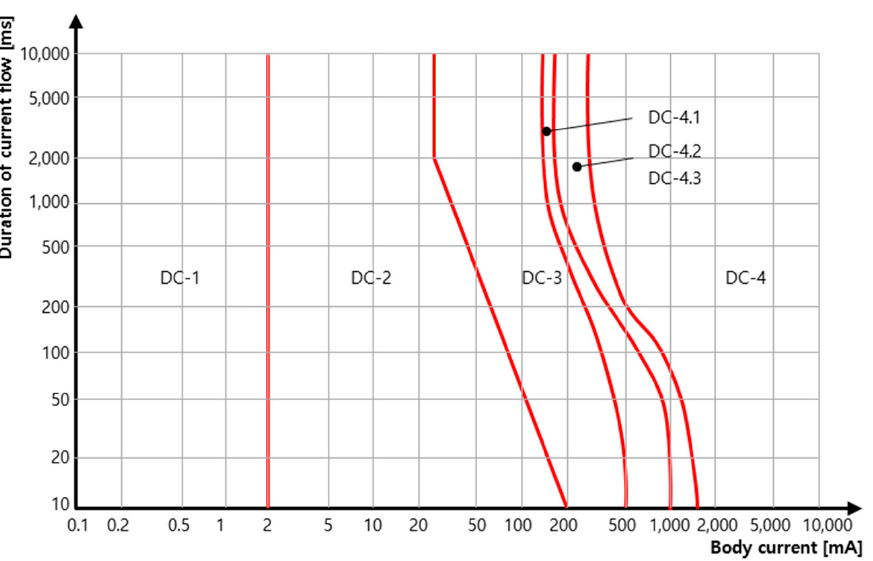
Figure 5. Graph illustrating the time/current zones of effects of DC current flow on the human body for a longitudinal upward current path (feet to left hand).